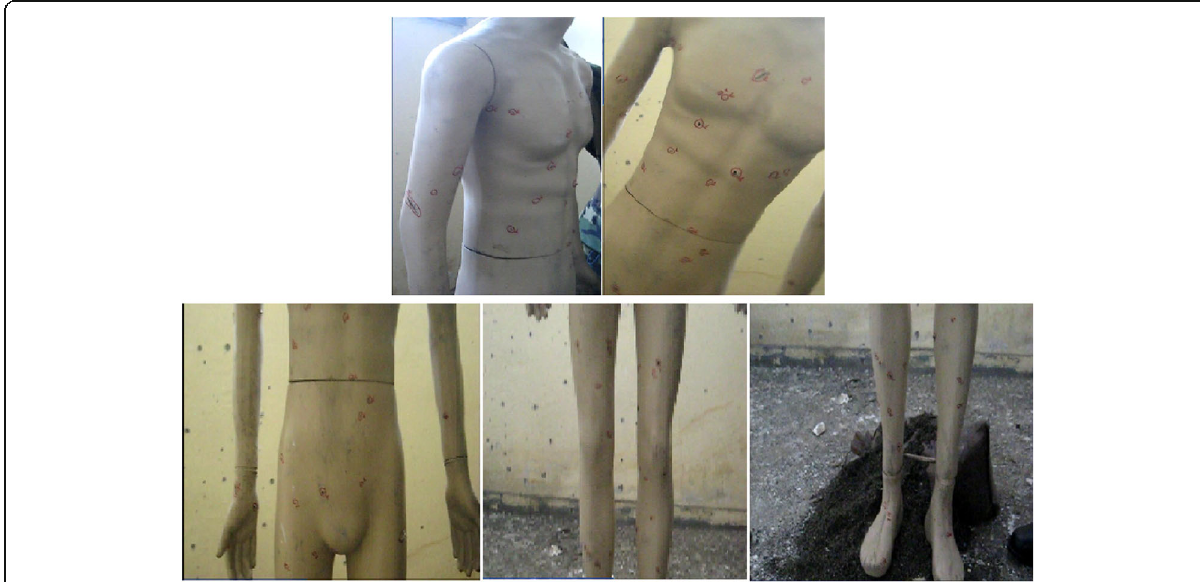
Fig. 15 1 Mannequin-3 (male 3-deceased) positioned as standing after detonation . 2 Mannequin-3 (male 3-deceased) positioned as standing after detonation